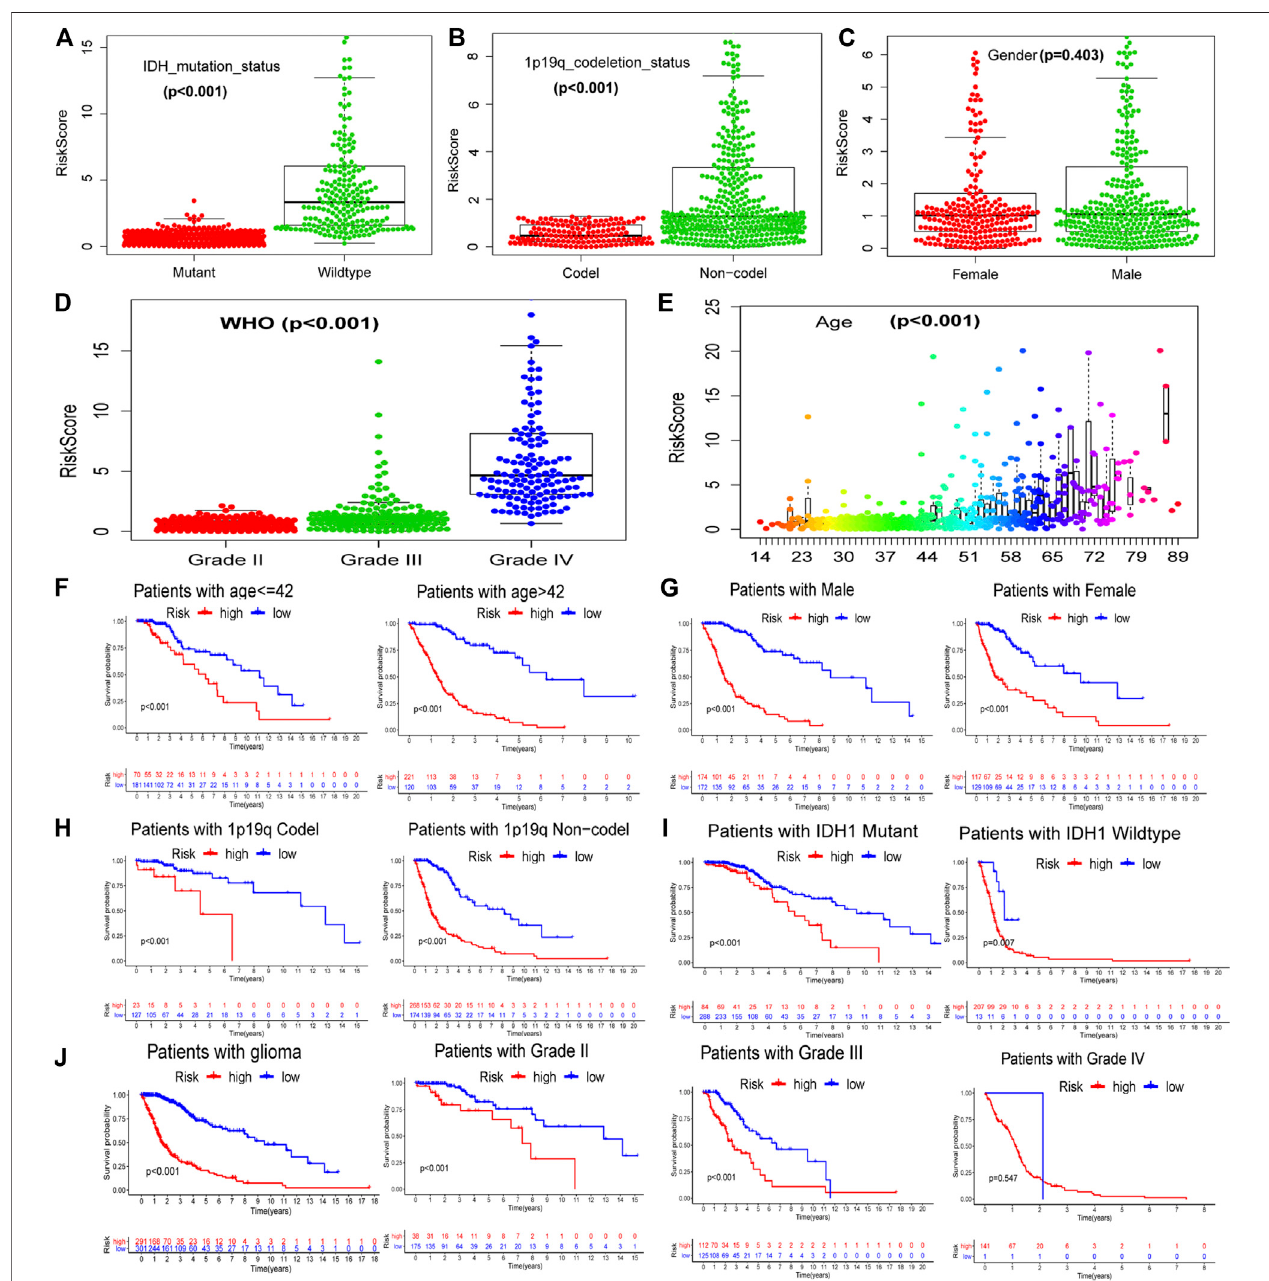
FIGURE4| RelationshipbetweenGILncSigandclinicalprognosisofpatientswithgliomaderivedfromTCGA.TherelationshipbetweenGILncSigscore(riskscore) andclinicalcharacteristics:IDHstatus (A) ,1p19qstatus (B) ,gender (C) ,WHOgrade (D) ,andpatientage (E) .Survivalcurvesofpatientsinthehigh-andlow-riskgroups based on the GILncSig score under different clinical characteristics: patient age (F) , gender (G) , 1p19q status (H) , IDH status (I) , and WHO grade (J) .